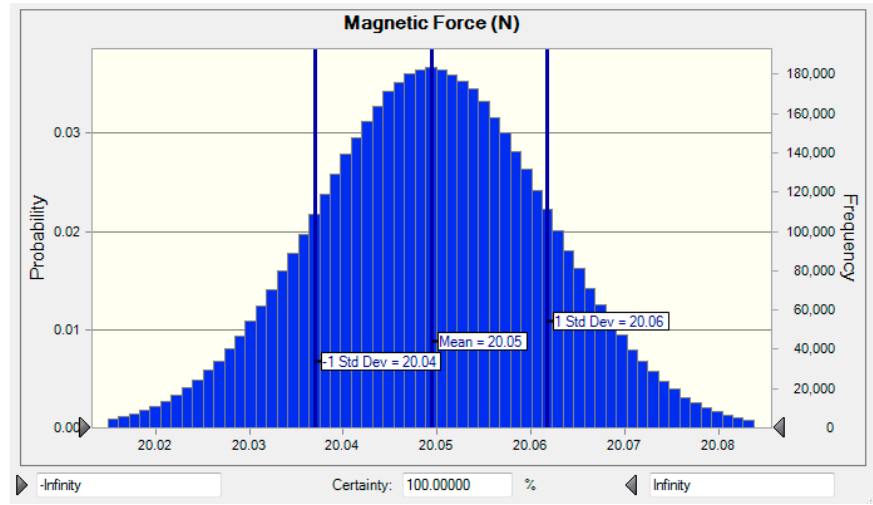
Figure 22. Performance distribution of electromagnetic force by 3 sigma level.